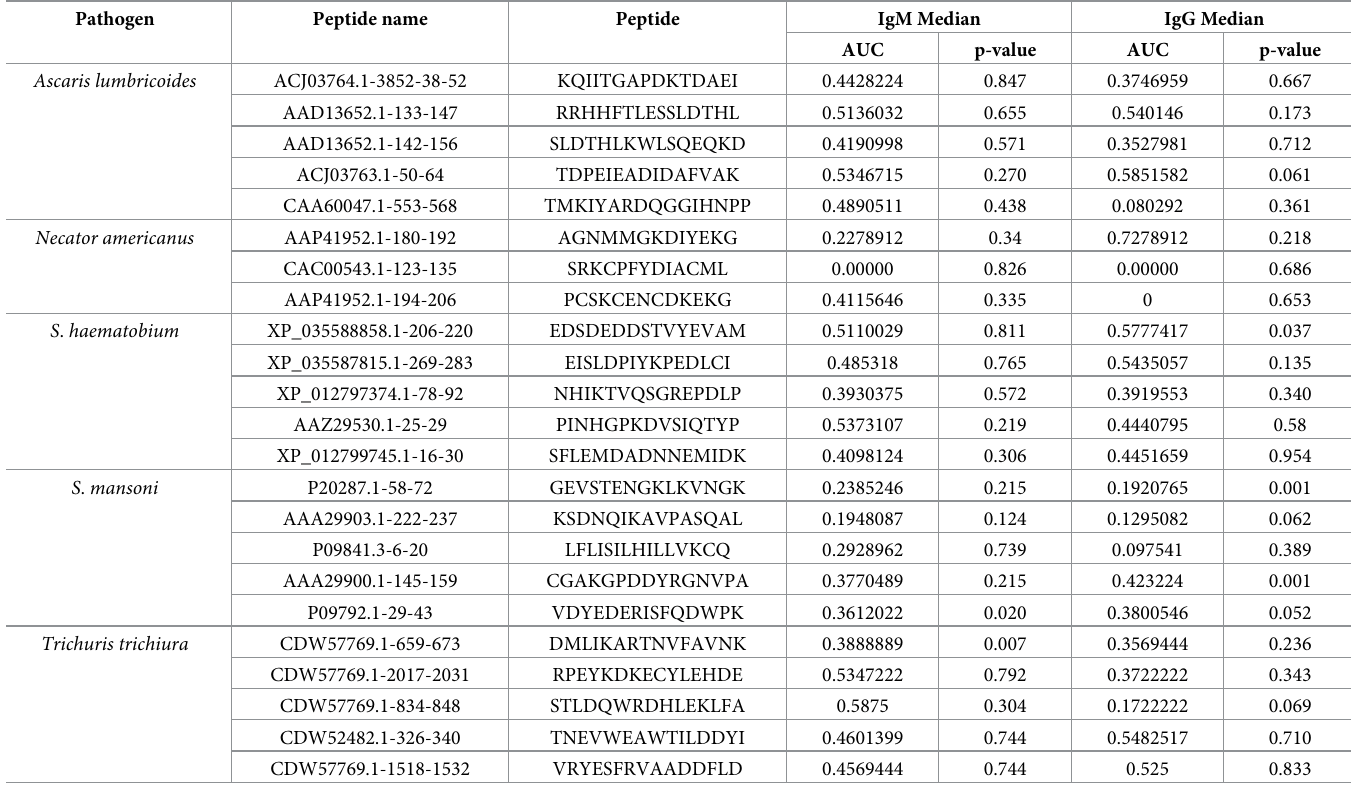
Table 3. Diagnostic performance of selected